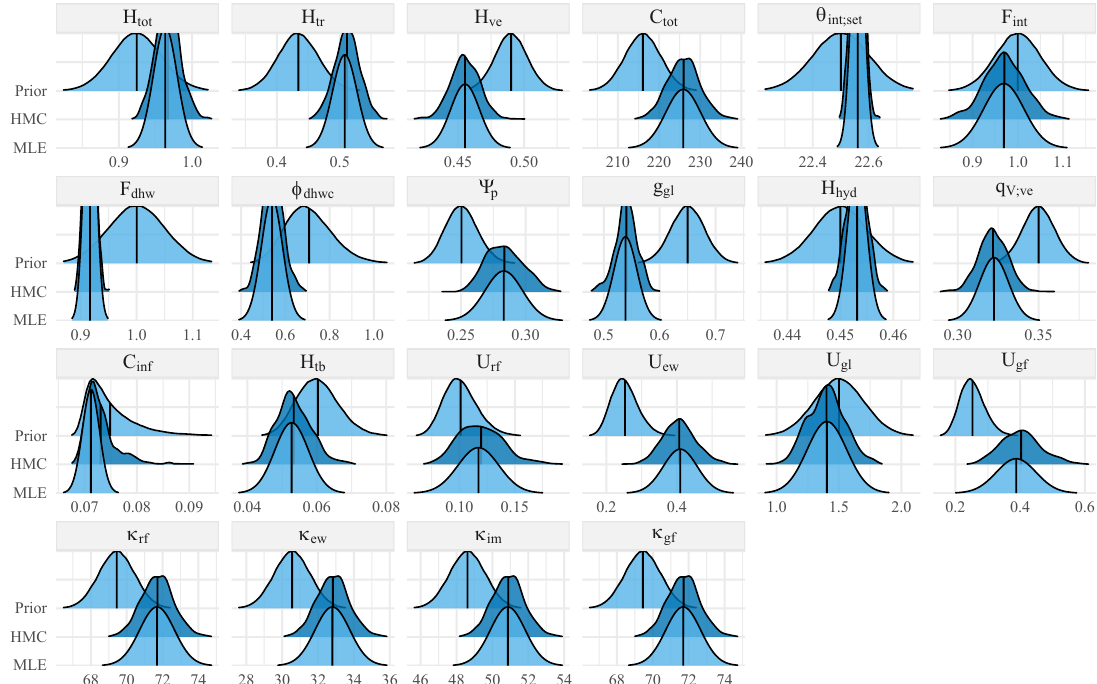
Figure 9. Parameter probability density distributions. Prior: the prior model; HMC: posterior inferred with Hamiltonian Monte Carlo sampling; MLE: posterior inferred with penalized maximum likelihood estimation. Vertical lines show mean values. Densities are scaled per parameter such that the mode of the prior has a relative height of 200%; densities below 0.01% are filtered out.